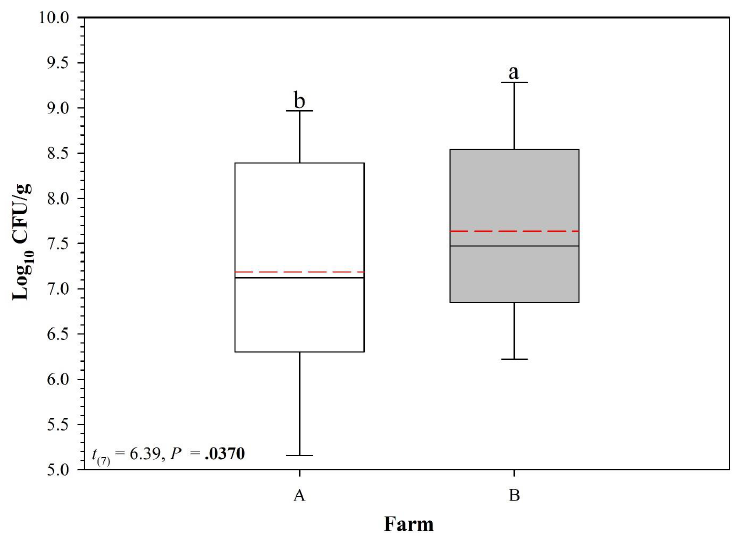
Figure 5. Comparison of virulent Aeromonas hydrophilia population (log 10 CFU g − 1 ) in soil samples collected from 2 farms (2 ponds/farm × 3 replicate tanks per pond), Within each box plot, solid black horizontal line indicates the median, dashed red horizontal line indicates the mean. Box plots with different lowercase letters are significantly different at p <